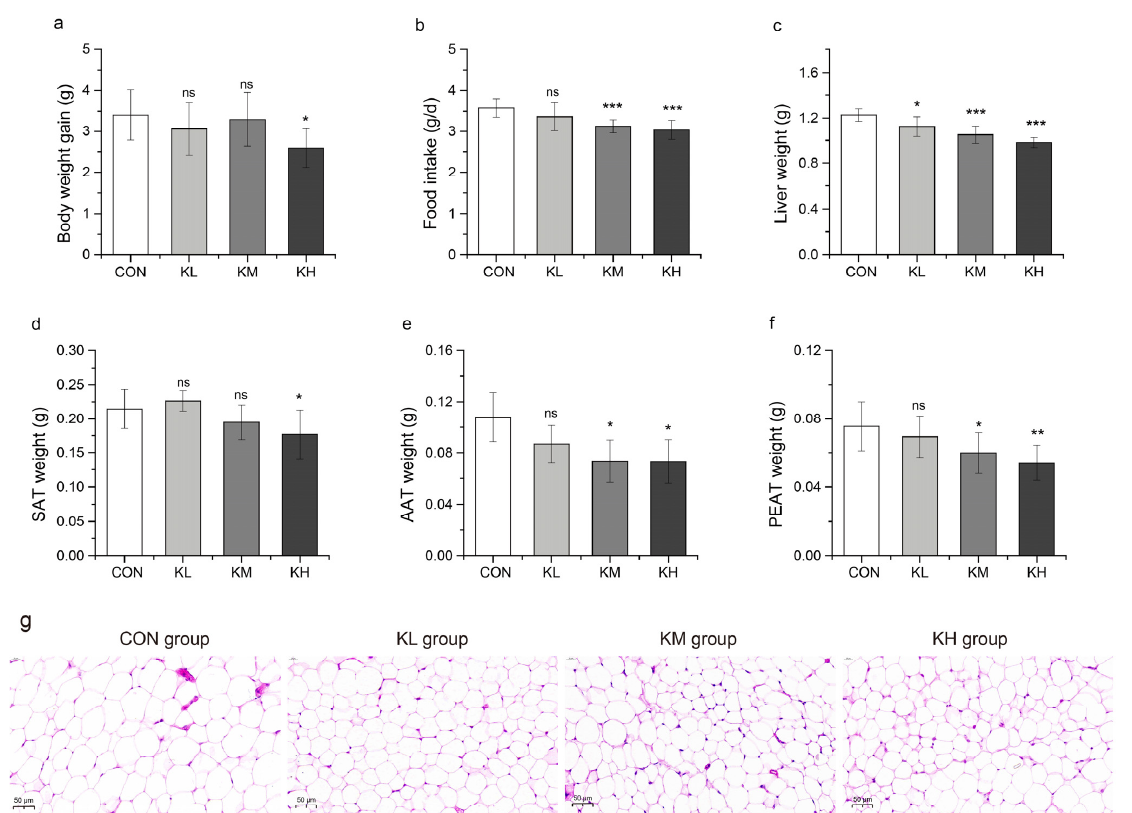
Figure 5. FKJ alleviated body weight gain and fat accumulation in mice (n = 7–10). ( a ) Body weight gain (in grams) after 8 weeks of FKJ supplementation (the control group was expressed as CON, and the groups supplemented with low-dose, medium-dose, and high-dose FKJ were expressed as KL, KM, and KH, respectively). ( b ) The average daily food intake of mice during the whole experi- mental period. ( c ) Liver weight, ( d ) subcutaneous adipose tissues (SAT) weight, ( e ) abdominal adi- pose tissues (AAT) weight, ( f ) perirenal adipose tissues (PEAT) weight. ( g ) The observation of AAT by H&E staining of four treatment groups (40×). * p < 0.05; ** p < 0.01; *** p < 0.001; and ns p > 0.05. Compared with CON group.